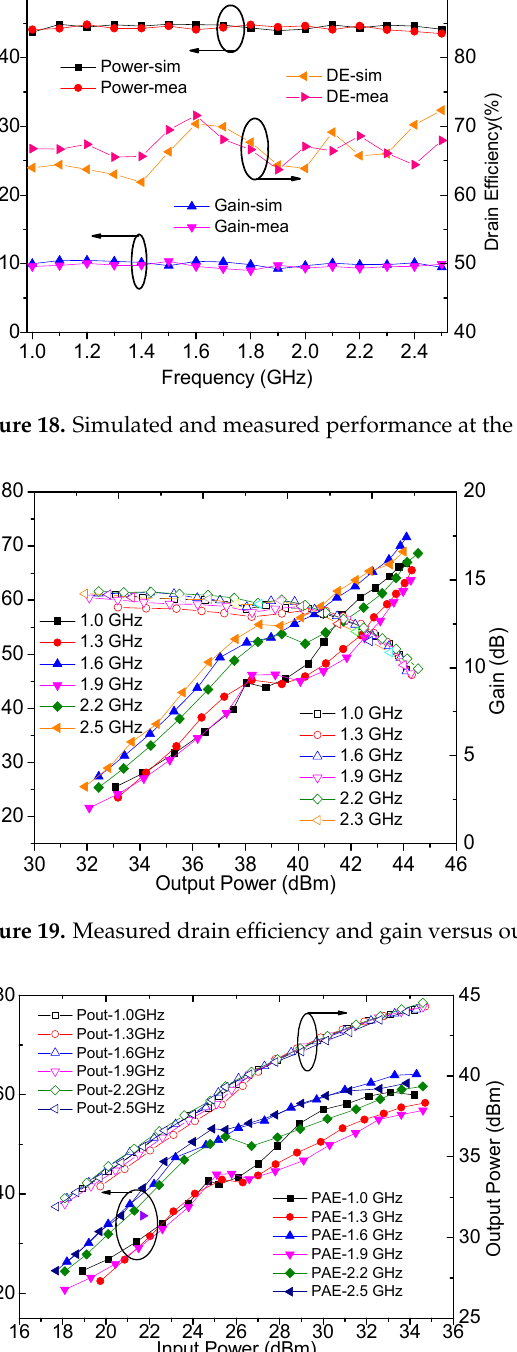
Figure 20. Measured power-added efficiency and output power versus input power.